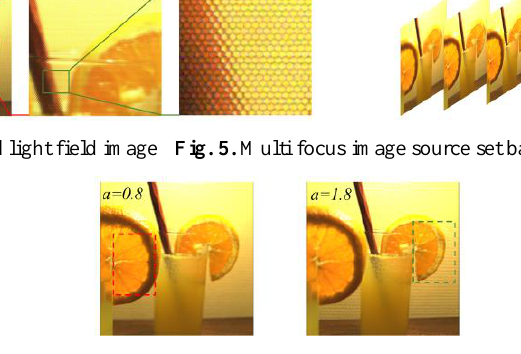
Fig. 6. Two refocused images with different spatial depths.